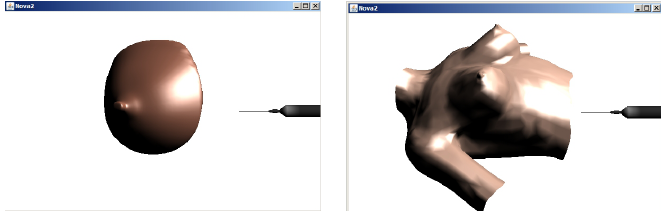
Figure 8. Example of applications of colocar and illumination models used in ViMeTGame .